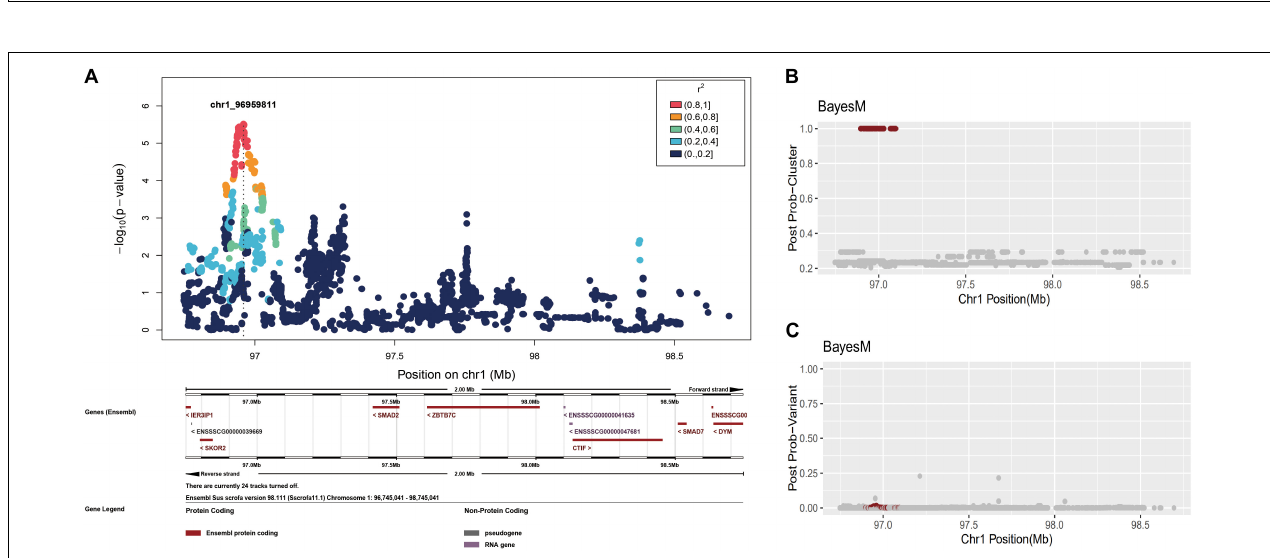
FIGURE 3 | Fine-mapping in the chromosome 1: 96,745,041–98,745,041 region. (A) Individual SNP association study and its locuszoom plot. (B) The posterior probability of clusters. (C) The posterior probability of SNPs.